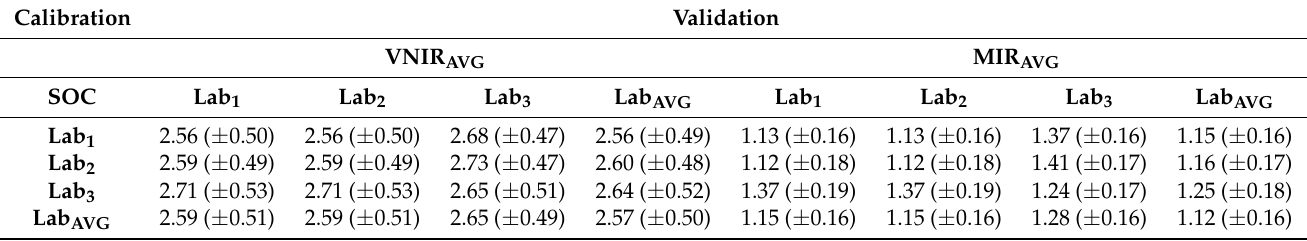
Table 7. Validation accuracy (RMSE in g · kg − 1 ) of VNIR and MIR SOC models for different combina- tions of calibration and validation laboratory SOC reference data using the averaged spectral data (VNIR AVG , MIR AVG ) for model calibration and validation (prediction). Statistics represent average RMSE values of 100 randomized runs of the nested cross-validation approach with two standard deviations of their respective distributions given in